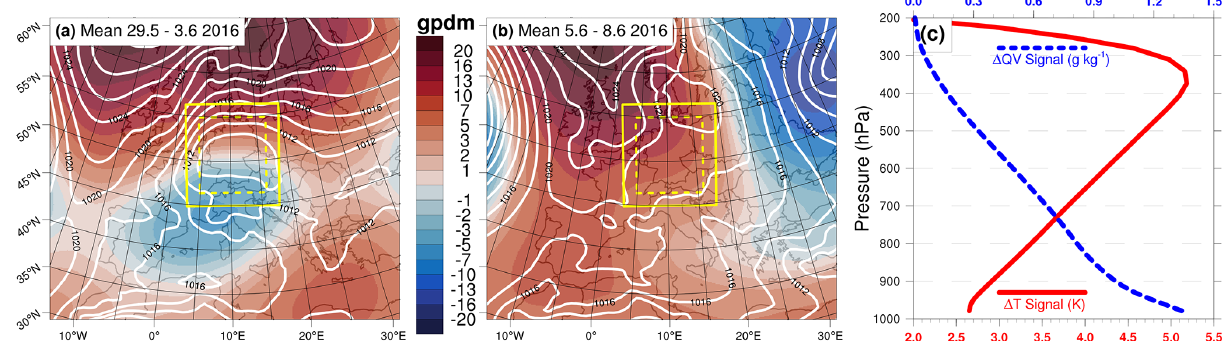
Figure 1. The 500hPa geopotential height anomaly (gpdm, shading; reference is the 1979–2015 mean) and sea level pressure (hPa, white lines) averaged over the periods (a) 29 May–3 June and (b) 5–8 June 2016. The maps cover the spatial extent of the 0.11 ◦ simulation domain, and the solid and dashed yellow lines mark the 0.025 ◦ simulation domain and analysis region, respectively. (c) The climate-change signals of temperature (T; red line) and specific humidity (QV; blue line) added to the initial and boundary conditions of the 0.11 ◦ PGW simulations. The signal is computed based on an area average over the 0.11 ◦ domain; change profiles for winds and pressure, as well as equivalent plots on height levels, are presented in Fig. S1.